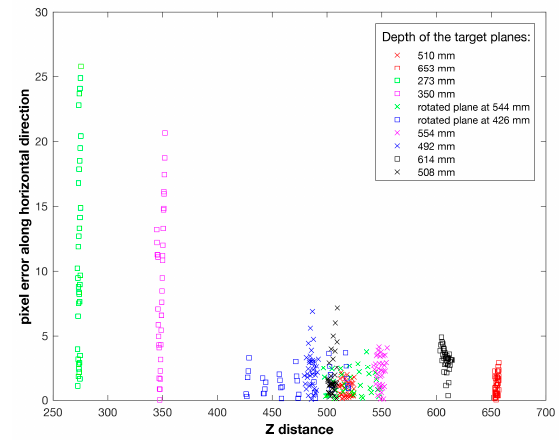
Figure 7. Horizontal monoscopic disparities.